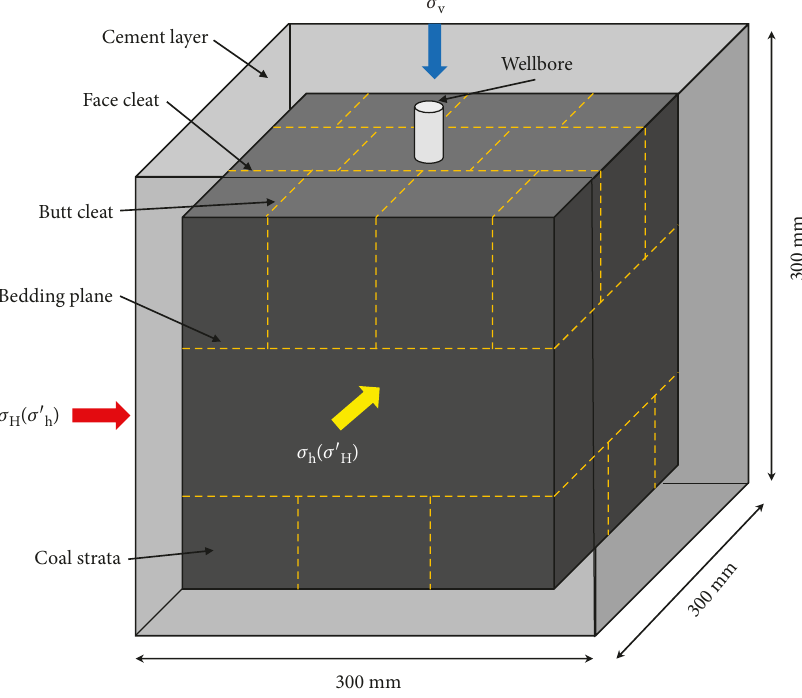
Figure 4: Internal structure of specimen. Table 2: Parameters used during refracturing simulation experiments in